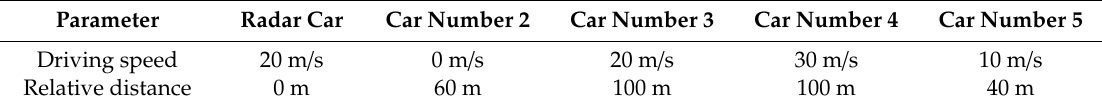
Table 2. Vehicle information in highway scene with heavy rain.